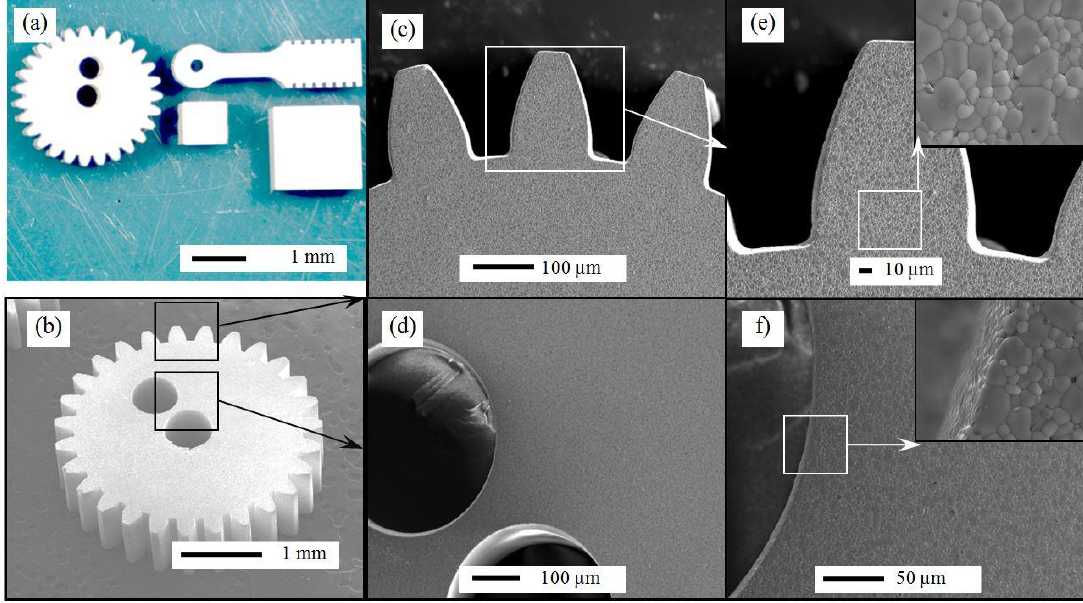
Figure 3. ( a ) Optical images of different green micro-parts. ( b – f ) scanning electron microscopy (SEM) images of sintered.